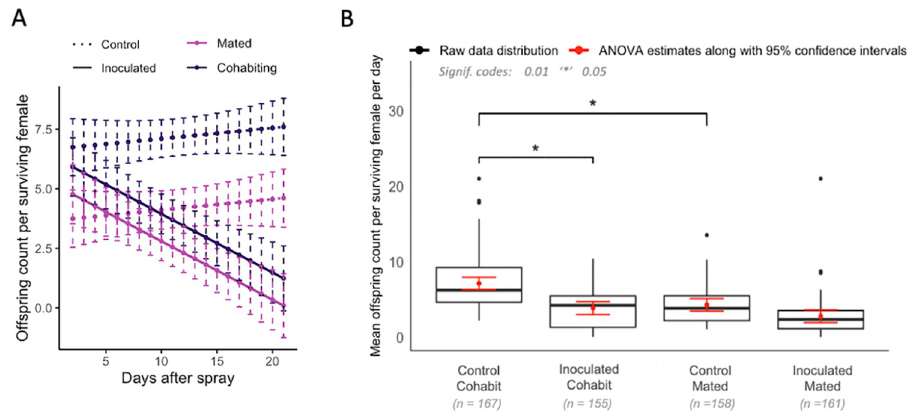
Fig 2. Reproductive output of mated and cohabiting females from both control and fungal inoculated conditions (Experiment 1). (A) Analysis of variance for the offspring counts produced by control (dashed lines) and fungal inoculated (solid lines) females at two different mating statuses, cohabiting (dark purple) and one-day mated (light purple). The data points are plotted for 95% confidence intervals. The fungal inoculated groups showed a lower offspring count in comparison to the control groups (p-value = < 0.0001). The mated groups showed a lower offspring count in comparison to the cohabiting group in control treatment (p-value = < 0.0001). There was an interaction effect between treatment (fungal/control) and mating status (cohabit/mated) with a p-value of 0.0373. (B) Box plot shows the raw data distribution of offspring counts per surviving female and predicted mean value for cohabiting and mated flies. Black dots represent the outliers while red lines represent the 95% confidence intervals. Control cohabiting females have a higher offspring count than the fungal cohabiting females (p-value = 0.0120) whereas there was no significant difference between offspring counts in control mated and fungal mated groups (p-value = 0.0870). Control cohabiting females had a significantly higher offspring count than the control mated (p-value = 0.0169). However, inoculated cohabiting and inoculated mated groups did not show a significant difference in offspring counts (p-value: 0.1771). The control cohabiting females (predicted mean: 7.124) have a lower offspring counts than fungal cohabiting females (predicted mean: 3.844) and the same was seen in control mated (predicted mean: 4.276) and fungal mated females (predicted mean: